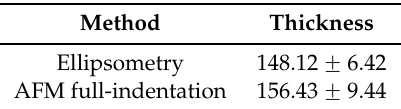
Table 3. Comparison of ellipsometry and the atomic-force microscopy (AFM) full-indentation method for measuring the thickness in water for sample 1.